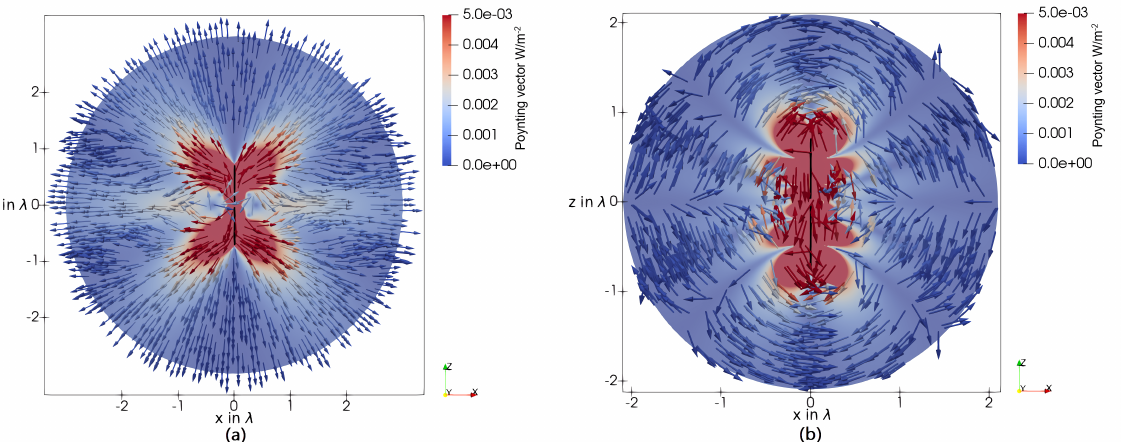
Figure 10. ( a ) The real part of the Poynting vector in the E-plane of a dipole antenna with an overall length of 1.5 λ . ( b ) The imaginary part of the Poynting vector in the E-plane of a dipole antenna with an overall length of 1.5 λ .